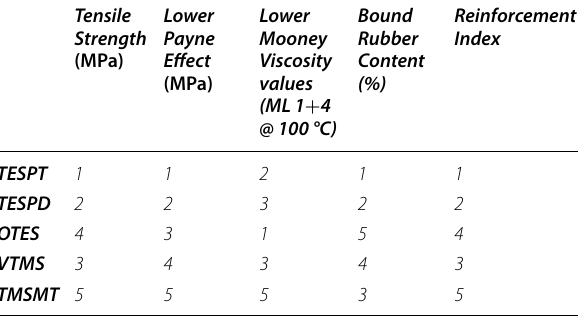
Table 4 Effect of different silanes on physio‑mechanical properties [42] (Ranking 1‑ Best and 5‑ Worst) BRC ‑Bound Rubber Content and R.I – Reinforcement